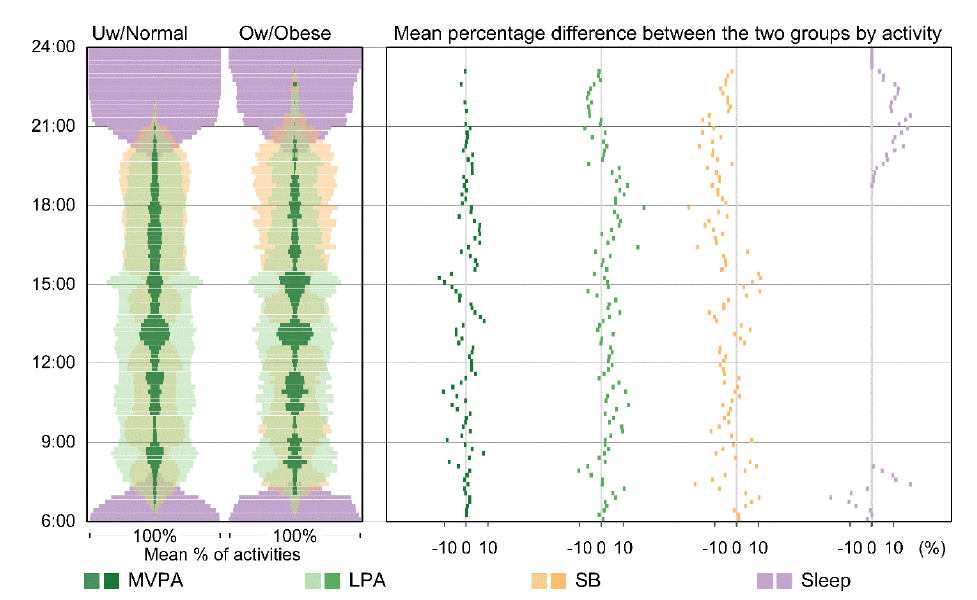
Figure 4. Time–Activity diagram showing aggregated time-use patterns of activities for the two weight status groups in the least deprived areas. The vertical dimension of the visualisation shows time of day from 6:00 at the bottom to midnight at the top. Activities are aggregated at 10-min intervals. The percentages of time in each interval are summed to 100 percent. The left panel shows the aggregated mean percentage of time spent on the different activities for the two groups. The mean percentage of time is presented as a proportional bandwidth. The right panel shows percentage differences between the two groups for each activity type. The percentage difference was calculated by subtracting the mean percentage of time for the overweight or obese group from that of the underweight or normal group (i.e., the underweight or normal group was the reference). Any results that appear on the right-hand side of the zero axis (positive values) indicate that the percentage of time spent on that activity was greater among underweight or normal children. Colours represent the four activity types: MVPA (dark green), LPA (light green), SB (orange), and sleep (purple). The colours in the left panel are semi-transparent in order to facilitate comparison of different compositional activity patterns both within each weight status group and between the two weight status groups.